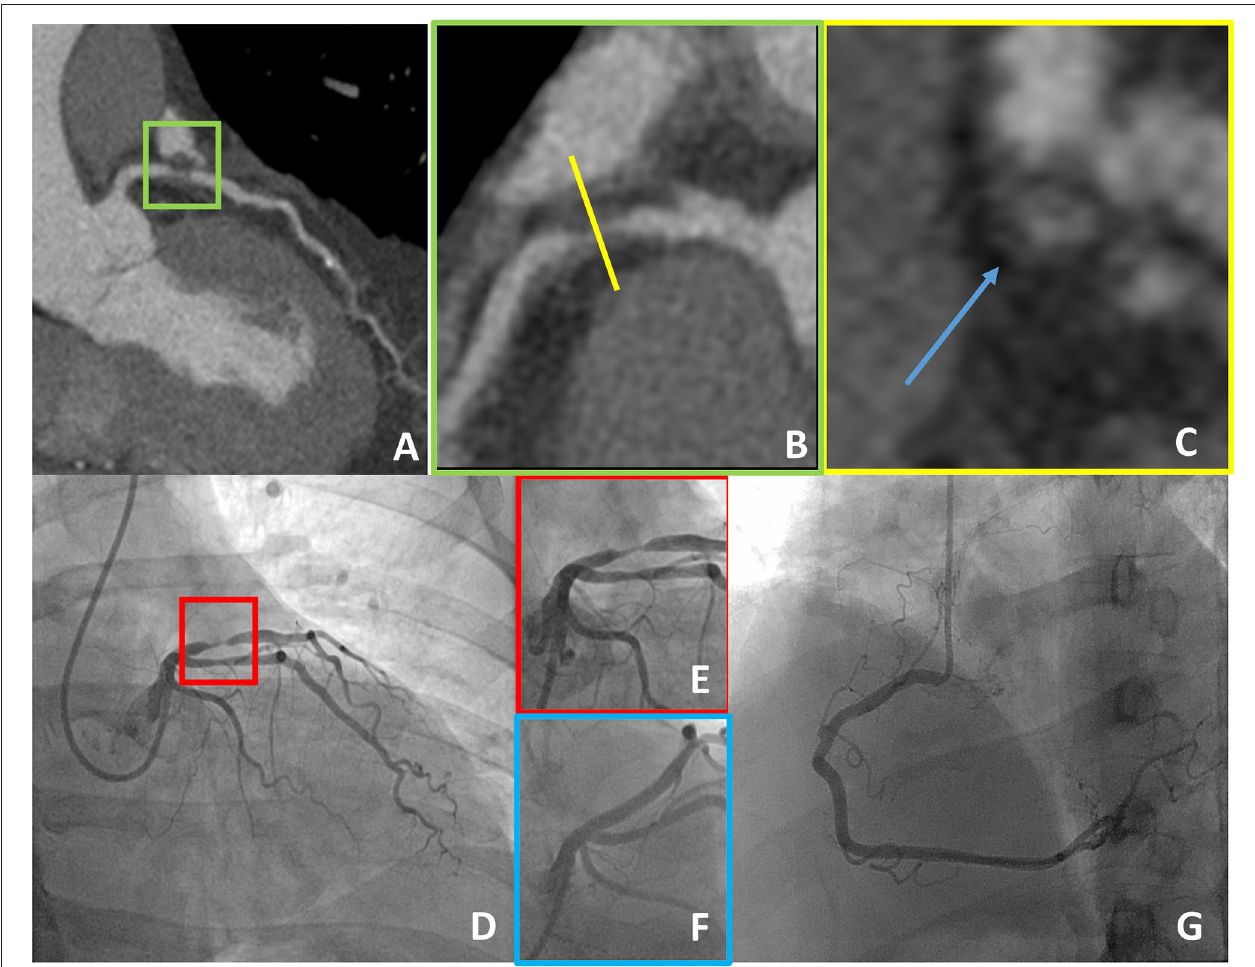
FIGURE 2 | A case example of a 55-year-old man with the typical chest pain in whom CCTA detected critical stenosis of the proximal LAD (A,B) , showing at the same time high-risk plaque features (positive remodeling and low-attenuation plaque as demonstrated in a short axis view, blue arrow in C ). The patient underwent ICA that confirmed subocclusive disease of the proximal LAD that was treated with PCI (D–G) . CCTA, coronary computed tomography angiography; LAD, left anterior descending artery; ICA, invasive coronary angiography; PCI, percutaneous coronary